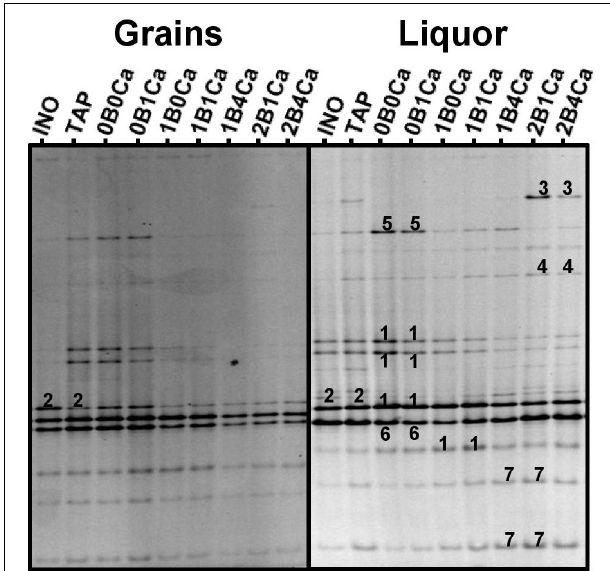
FIGURE 2 | Community profiles obtained with the V3 primer pair for the water kefir grains (left) and water kefir liquors (right) of the inoculum (INO) and eight water kefir fermentation series differing in the buffer capacity and calcium concentration of the water used for fermentation at the end of backslopping step 8. The numbers indicate the bands that were sequenced and the closest known type strains of the sequenced fragments are given. With the V3 primer pair: 1, Lactobacillus nagelii / ghanensis (99% identity for both species; GenBank accession no. NR112754/NR043896); 2, Lactobacillus hilgardii / diolivorans (100% identity; accession nos. LC064898/NR037004); 3, Leuconostoc pseudomesenteroides (99% identity; accession no.